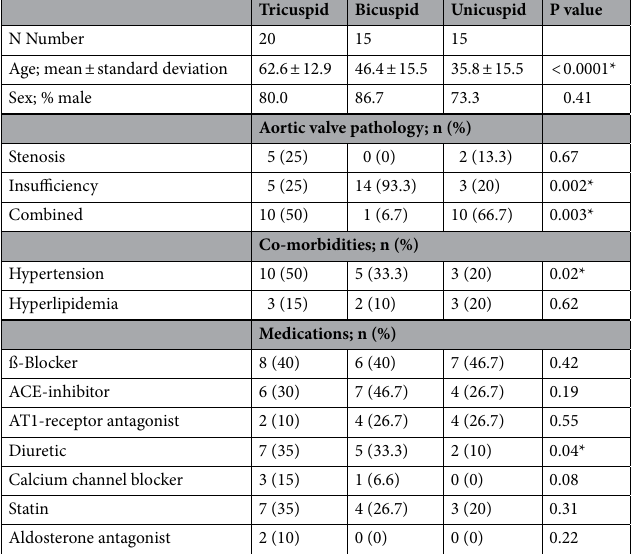
Table 1. Patient characteristics based on aortic valve morphology. *Statistical significance.